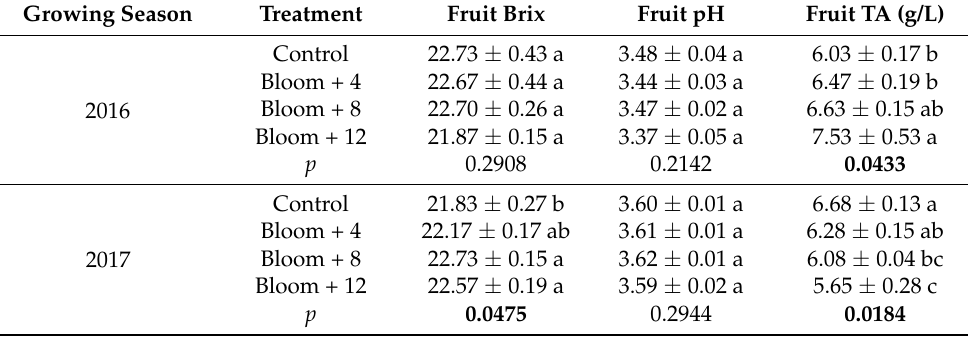
Table A2. Fruit chemical composition by treatment and growing season. Treatment means followed by standard error of the mean. Different letters within a column and growing season indicate significant differences between treatment groups for Fisher’s LSD at p < 0.05. p values below 0.05 are shown in bold fonts. TA—titratable acidity.